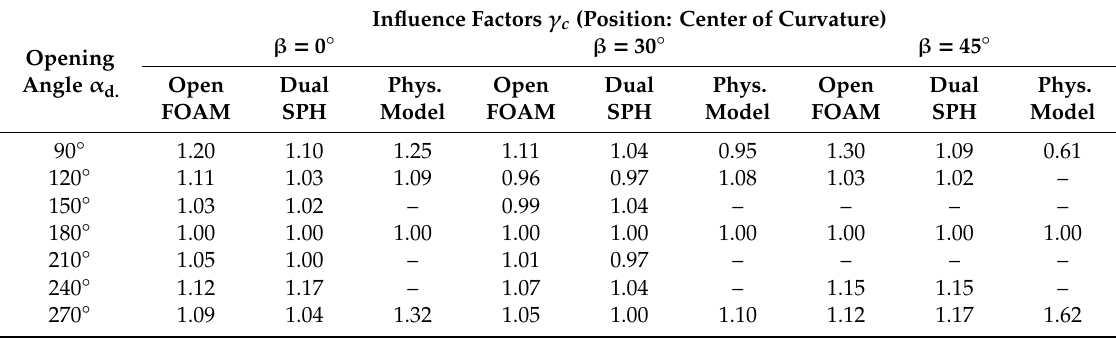
for different opening angles with different angles of wave 𝑐